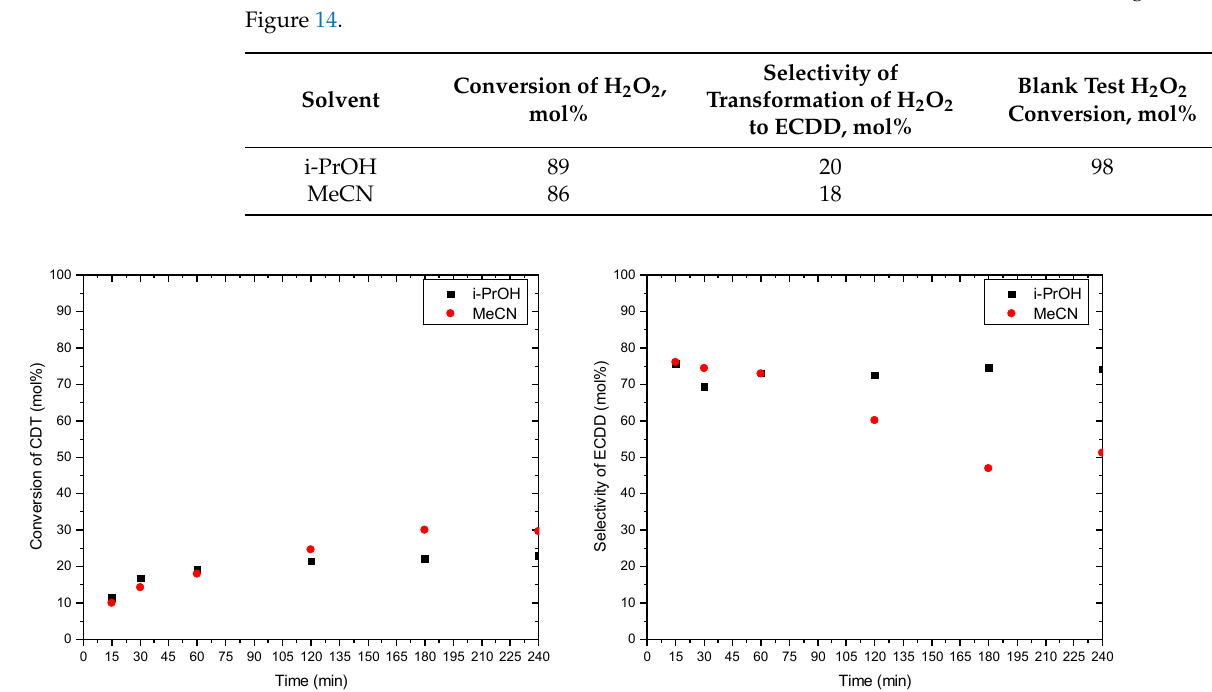
Table 4. Values of the conversion of H 2 O 2 and selectivity of transformation of H 2 O 2 to ECDD obtained after 4 h of reaction with two tested solvents. Reaction conditions were as given for Figure 14.